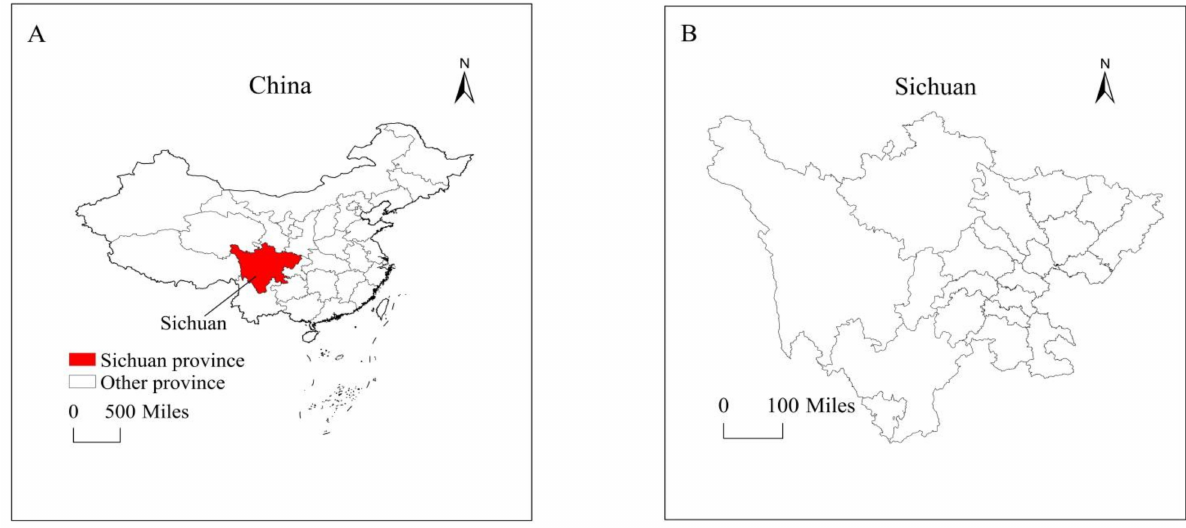
Figure 3. Map of the study